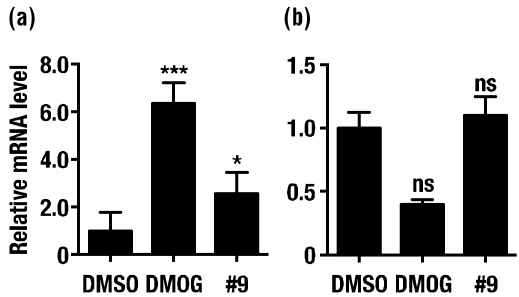
Figure 7. Expression levels of CA9 ( a ) and HIF-1 α mRNA. ( b ) SK-N-BE(2)c cells were stimulated with DMOG (100 µ M) and compound 9 (100 µ M) under hypoxic conditions (3% O 2 ). Gene induction is presented as relative mRNA levels, with the qRT-PCR values from DMSO-treated cells set as 1 for